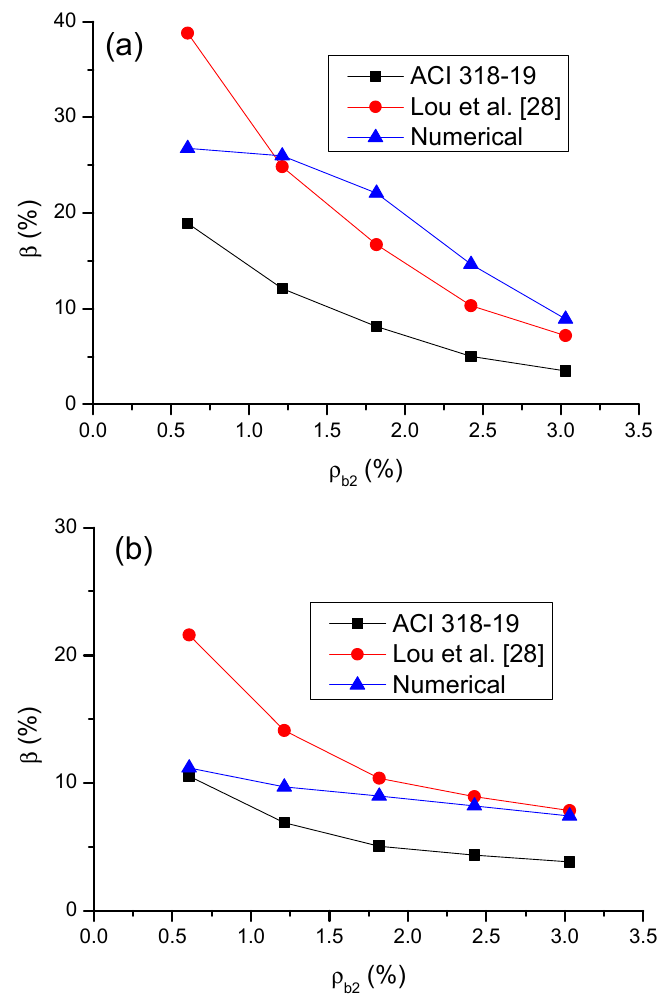
Figure 17. Comparison of the β – ρ b 2 relationships by simplified equations with numerical simulations: ( a ) steel RC beams and ( b ) CFRP RC beams.